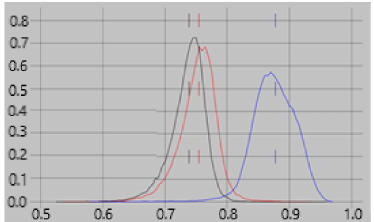
Figure 2. Feature contribution to classification accuracy. Histograms of the contribution of feature #1 to classification accuracy are shown for empty-room vs. rest (red), empty-room vs. task (black), and rest vs. task (blue). See text for details. Of the four features used in the classifications, #1 depends most heavily on the direction of current flow. It is expected to make a greater contribution to classifiers for one brain state vs. another than for a brain state vs. empty-room results. The figure confirms this